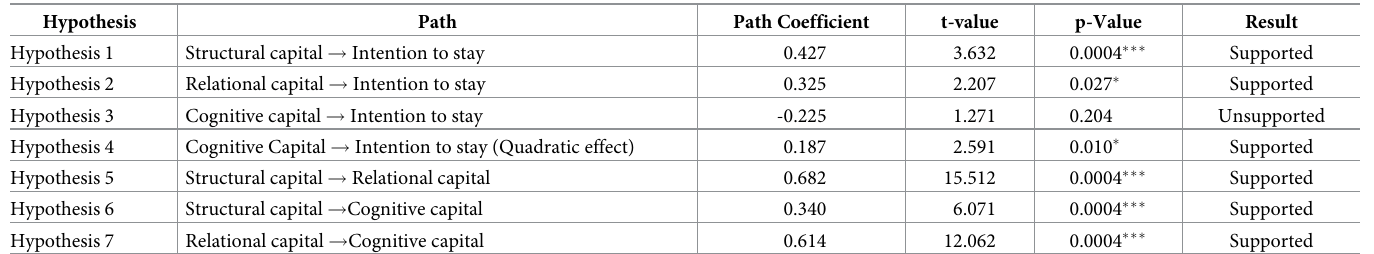
Table 5. Results of hypothesis testing.